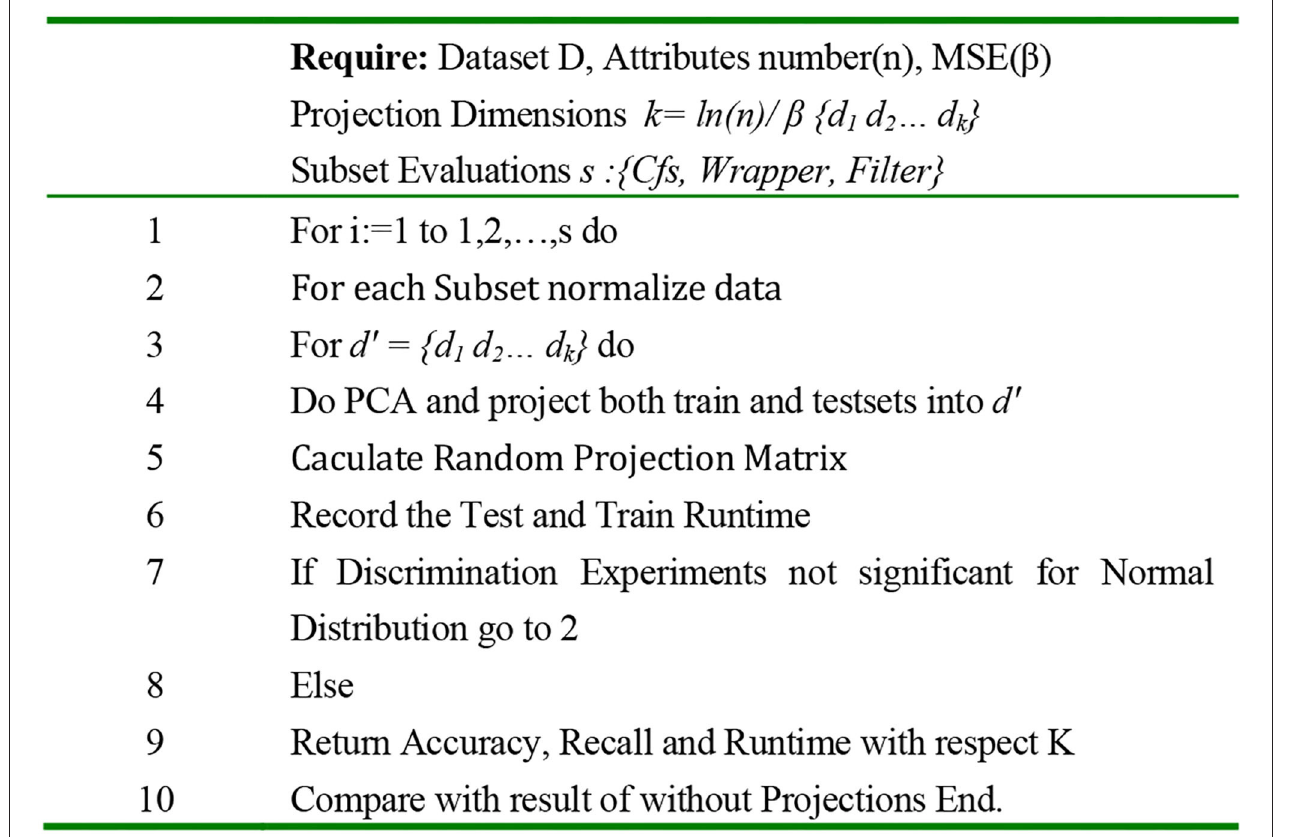
FIGURE 8 | Algorithm